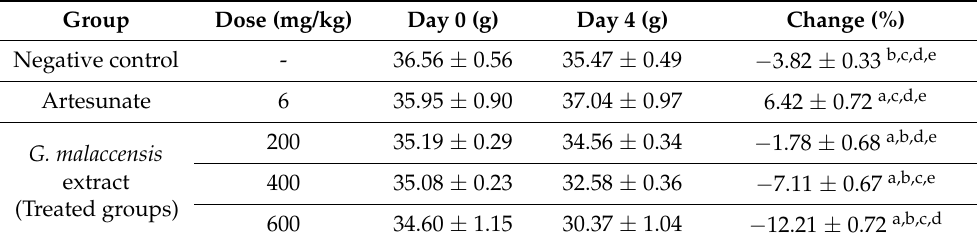
Table 6. Effects of the ethanolic G. malaccensis extracts on body weight changes in Plasmodium berghei -infected mice in the 4-day suppressive